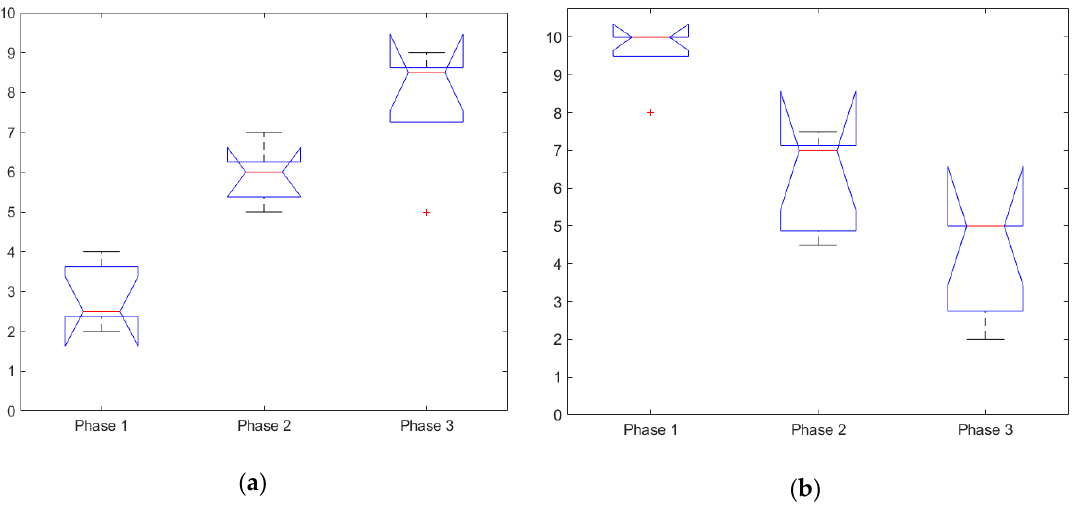
Figure 4. Subjective ratings: ( a ) subjective workload of all participants, grouped by the scenario phase and ( b ) subjective situational awareness of all participants, grouped by the scenario phase.